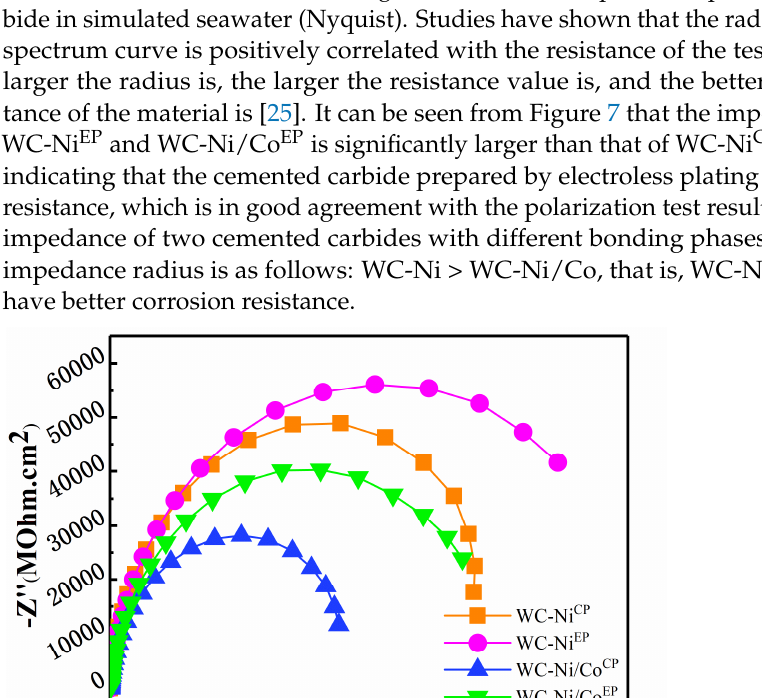
Table 5. Electrochemical and fitting circuit parameters of cemented carbide in simulated seawater.